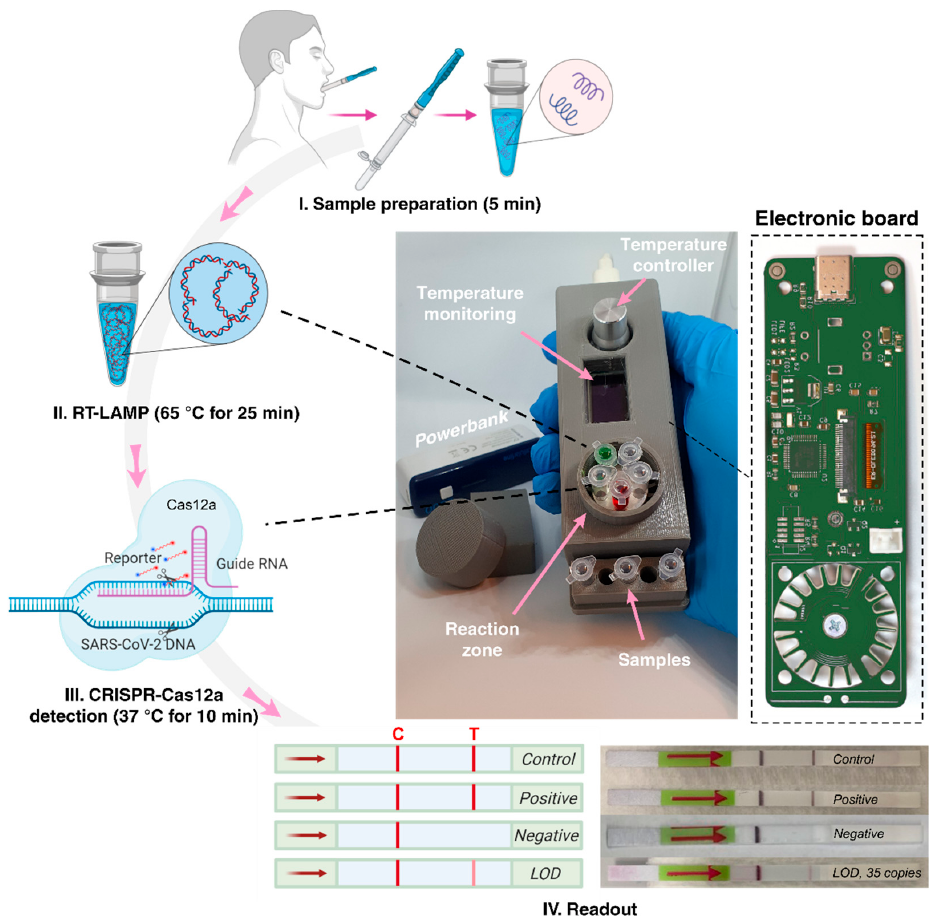
Figure 2. Schematic representation of the experimental procedure for the detection of SARS-CoV-2 with a portable device using an RT-LAMP/CRISPR-Cas12a approach. The workflow includes SARS-CoV-2 virus sampling from confirmed patients, virus deactivation and RNA extraction, RNA transcription and amplification by RT-LAMP, Cas12a reaction, and lateral flow strips visualization. Our portable device, along with its integrated electronic board, is demonstrated at the center of the figure. Samples in red and green are food dye for better illustration.